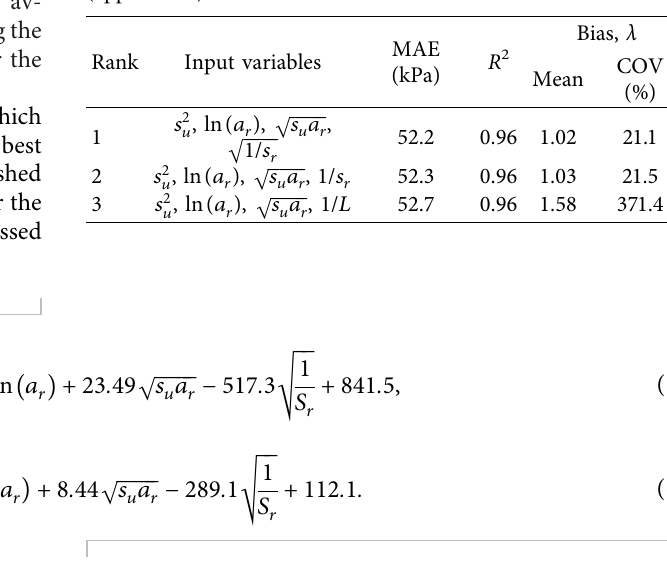
Table 6: Cross-validation error evaluation for input variables (approach